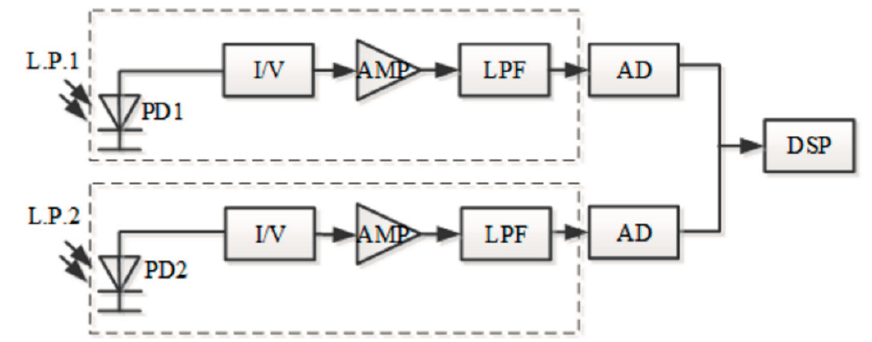
Figure 7. Module design of the acquisition circuit board.